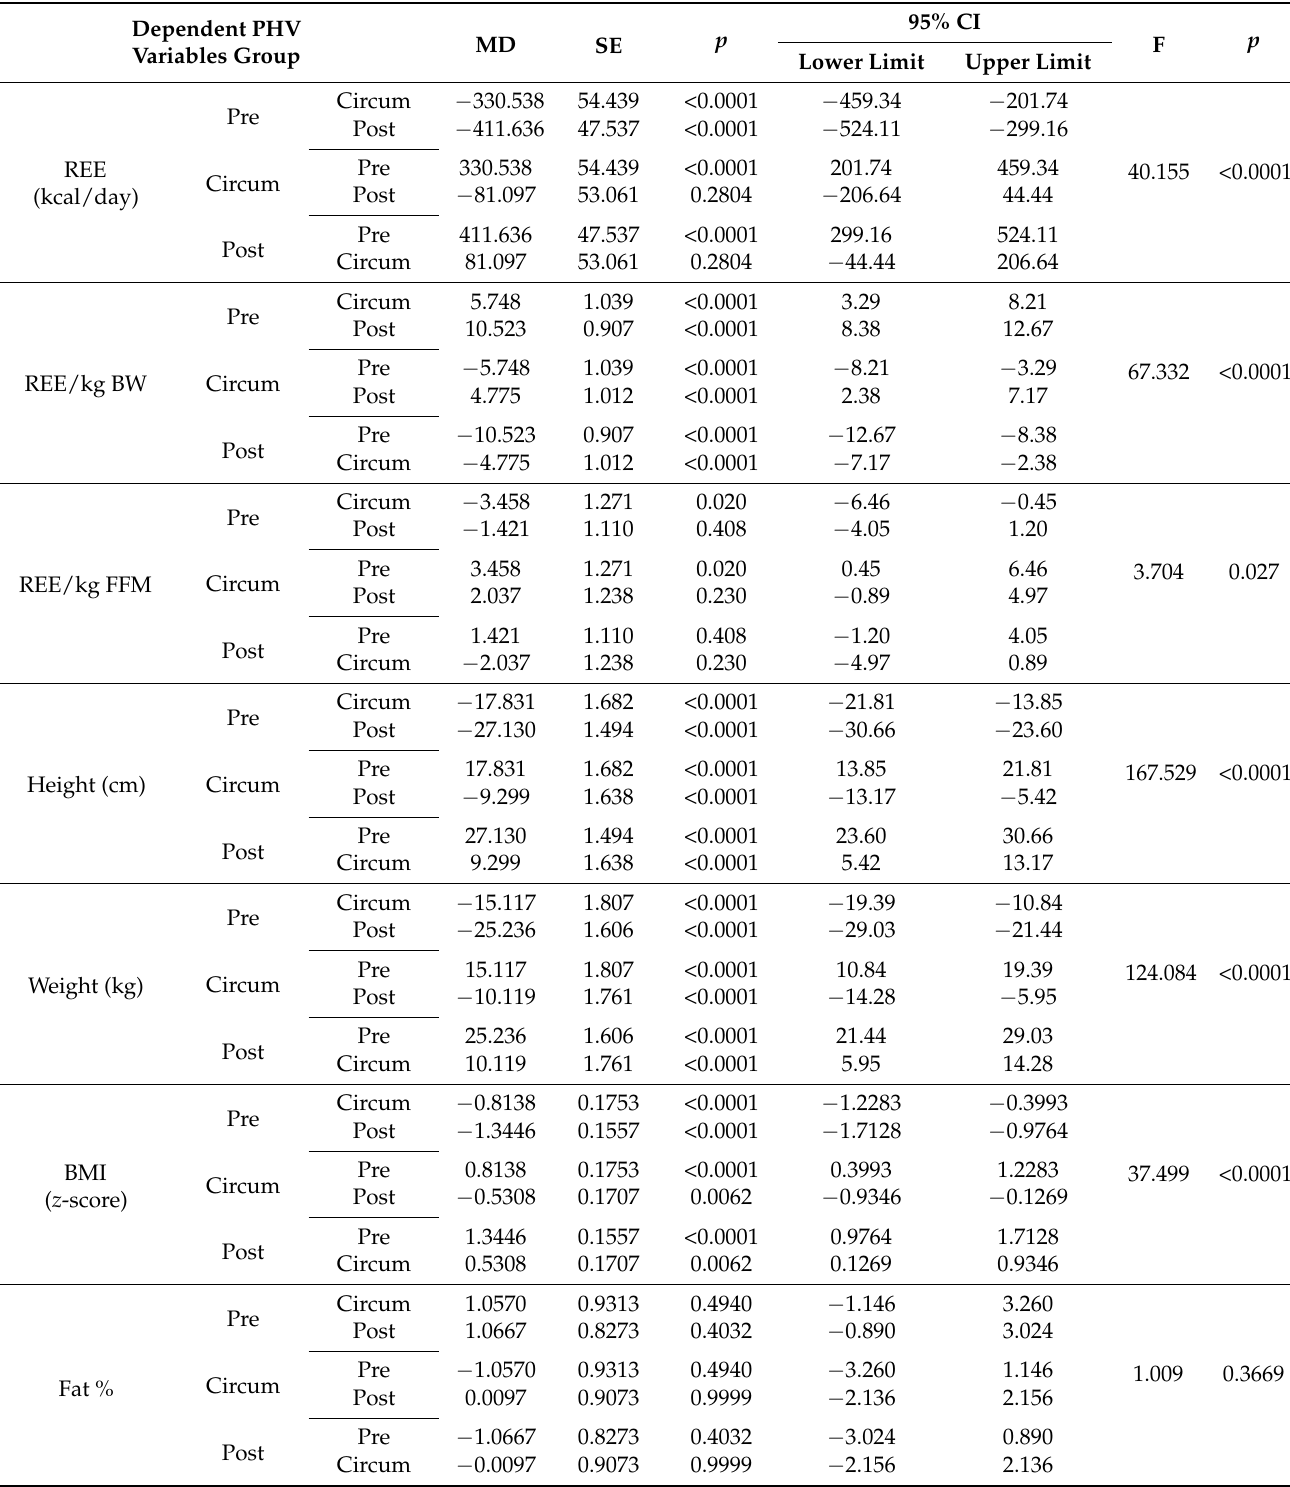
Table 2. Values of individual parameters depending on the PHV periods (multiple